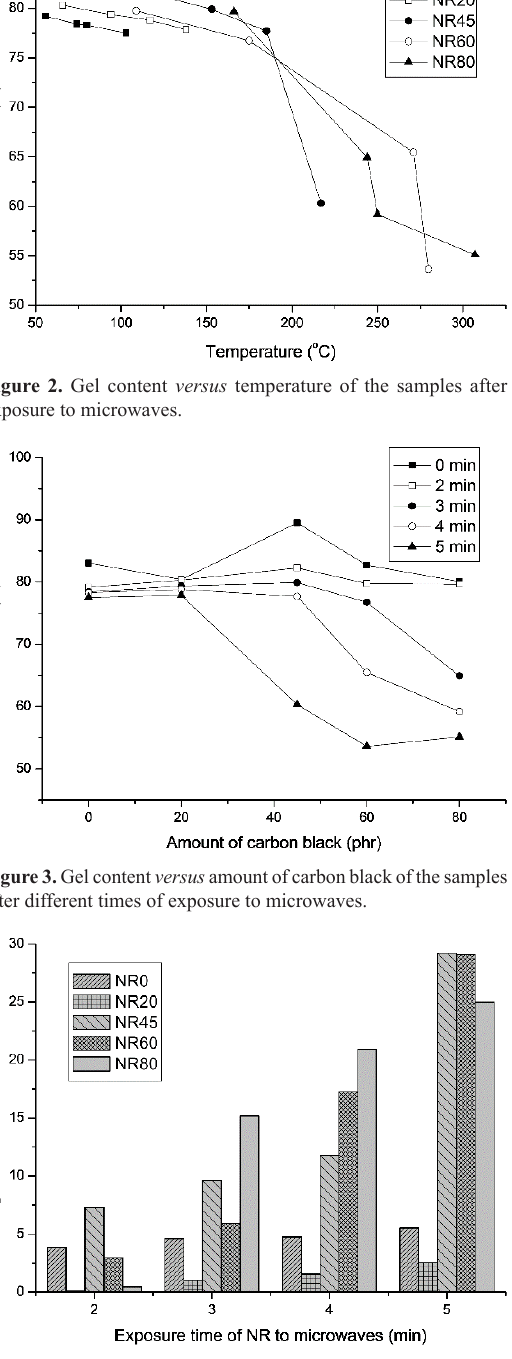
Figure 4. Degree of devulcanization of the NR with controlled composition of carbon